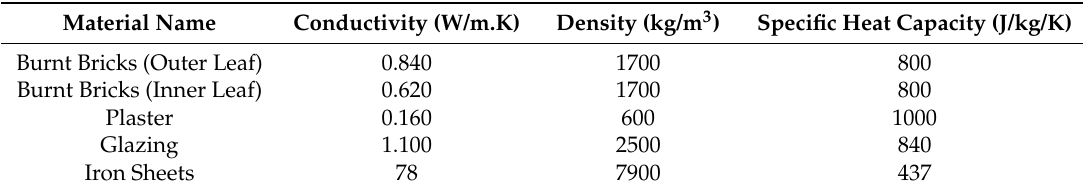
Table 2. Thermal properties of Malawian urban residential buildings’ construction materials. Source: Szokolay